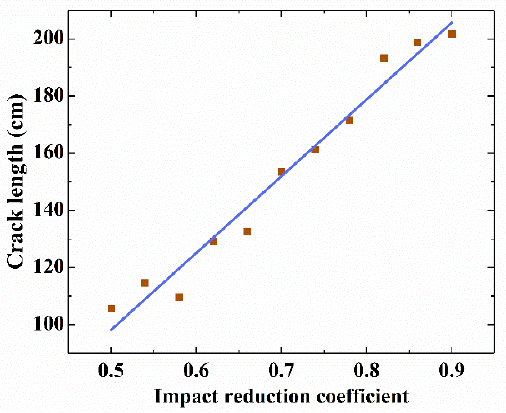
Figure 12. Relationship between crack length and impact reduction coefficient.